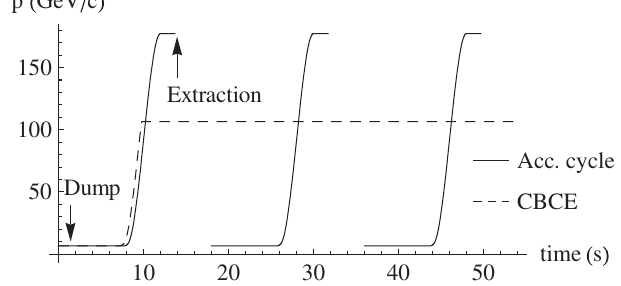
FIG. 6. (Color) Vertical betatron orbits coming out of the colli- mator, starting at y ¼ 0 , for different starting values of y 0 (vertical momentum normalized by longitudinal momentum). The collimator is located at s ¼ 5222 m at the left edge. The vertical dashed lines indicate the location of the four BLMs closest downstream. Particles with large vertical angles are lost close to BL520.